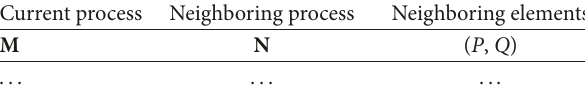
Figure 4: Mapping of meshes. Table 1: Topology